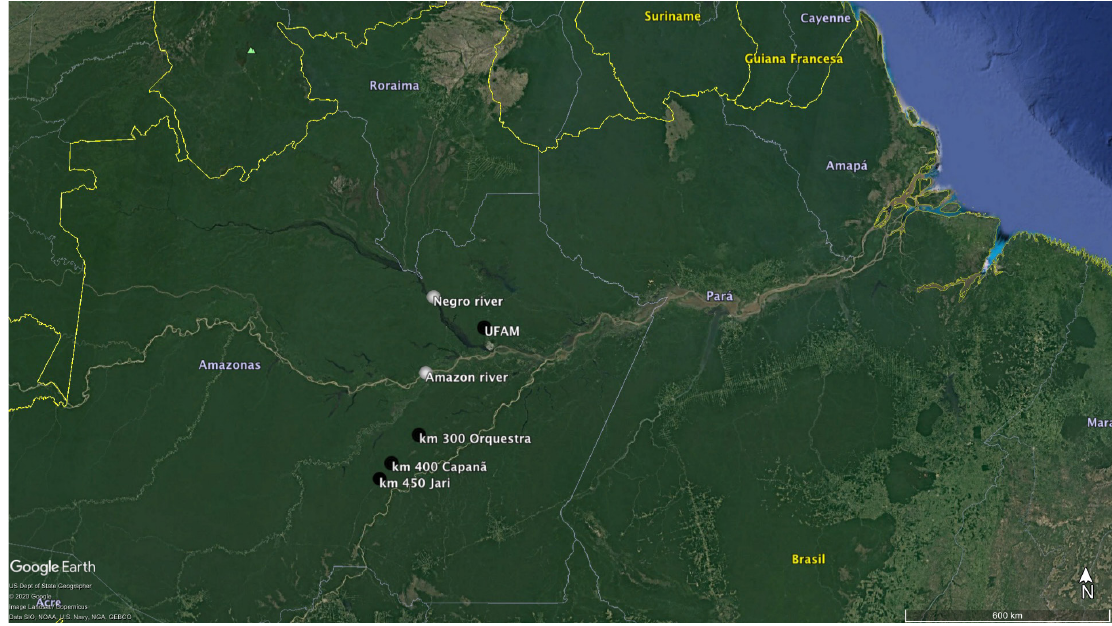
Fig 1 . Location of the four sampling sites in the Brazilian